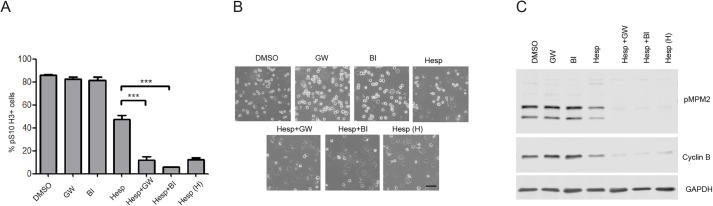
PLK1 inhibitors and Aurora B inhibitor cooperate to weaken the checkpoint. (A) Cells were treated with nocodazole for 12 h, collected by mitotic shake-off and re-plated in the presence of nocodazole minus/plus 1 μM GW843682X (GW), 100 nM BI 6727 (BI), 100 nM Hesperadin, both 1 μM GW843682X and 100 nM Hesperadin (Hesp+GW), both 100 nM BI 6727 and 100 nM Hesperadin (Hesp+BI), or 500 nM Hesperadin (Hesp H) as positive control. Cells were then collected, stained with anti-Histone H3 pSer10 antibody and analysed by FACS. 10,000 cells were counted for each treatment per repeat. Error bars are s.d. ***P<0.001, N=3. One-tailed t-test was used. (B) DIC images of A captured at the time of harvesting the cells. Scale bar: 50 μm. (C) Cells were treated as in A and western blot analysis was carried out using the indicated antibodies.